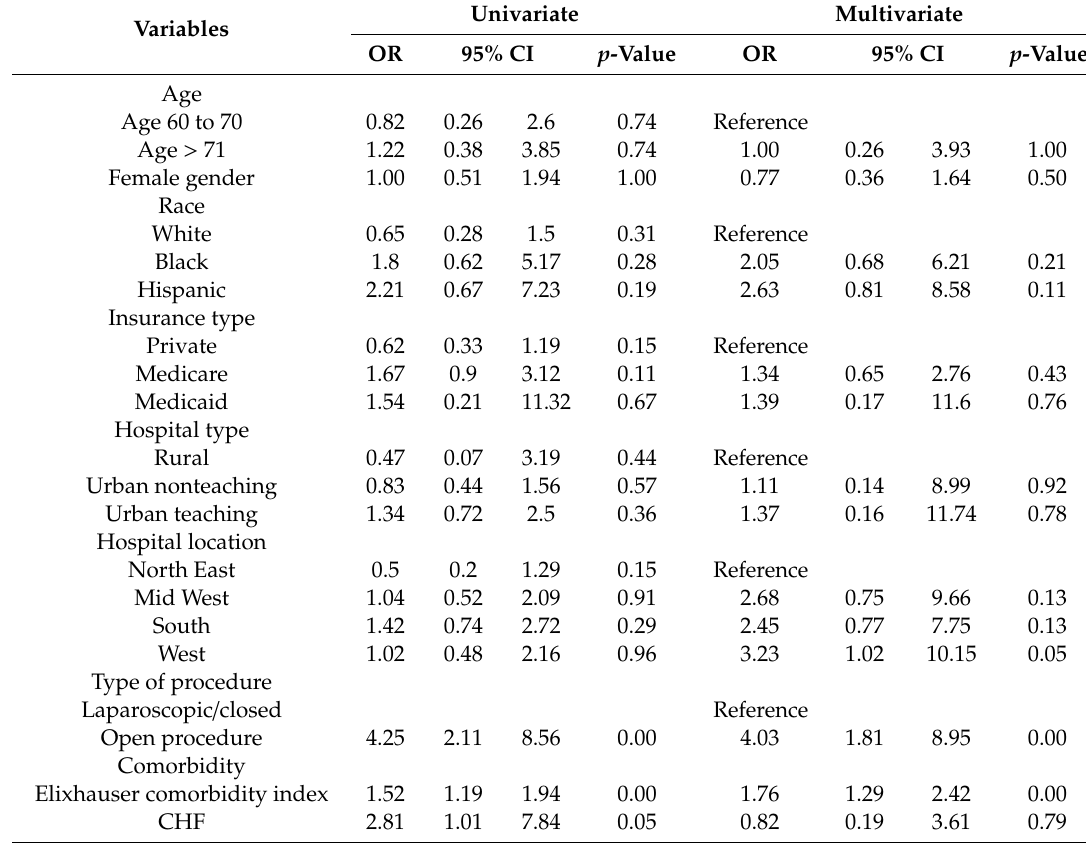
Table 3. Risk factor analysis for in-hospital mortality among patients undergoing bariatric